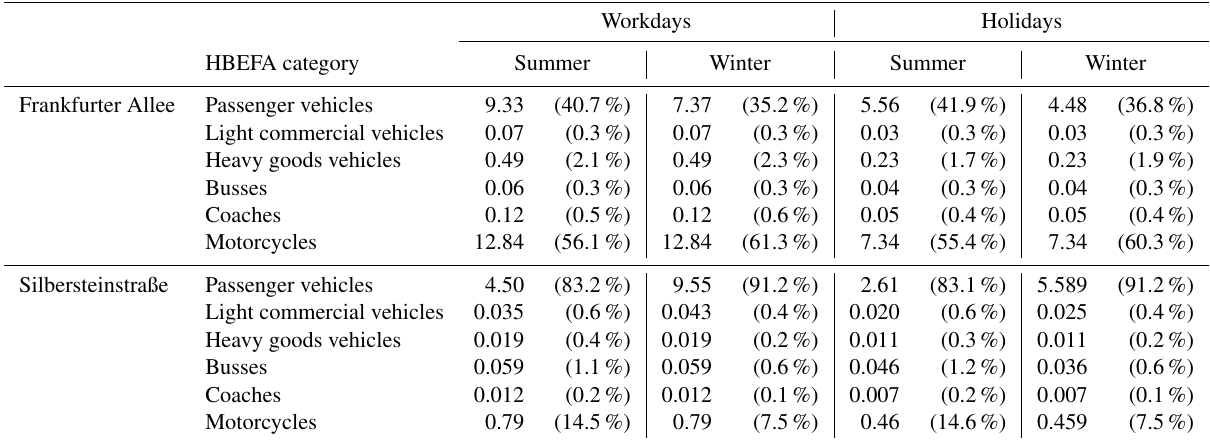
Table 9. Total daily HC emissions [kg] for typical workdays and holidays from Yeti using mean summer and winter temperature profiles on Frankfurter Allee in Berlin, classified by HBEFA vehicle categories.